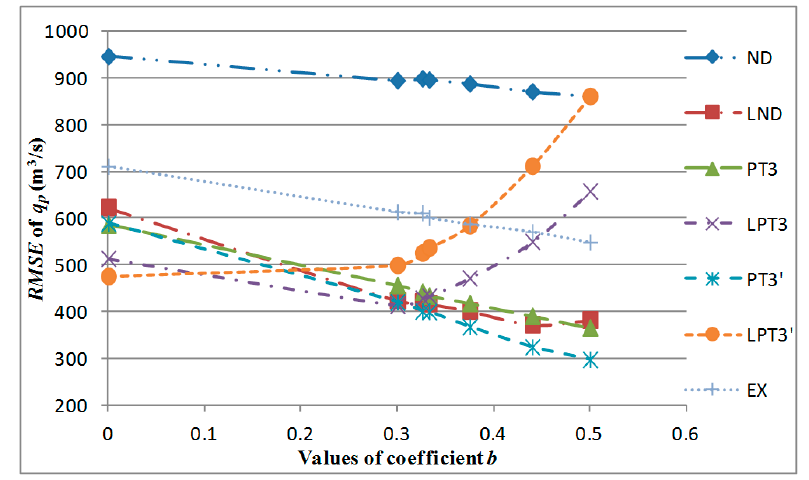
Figure 6. Values of RMSE for various probability functions for peak inflow ( q p ) of Shih-Men Reservoir.